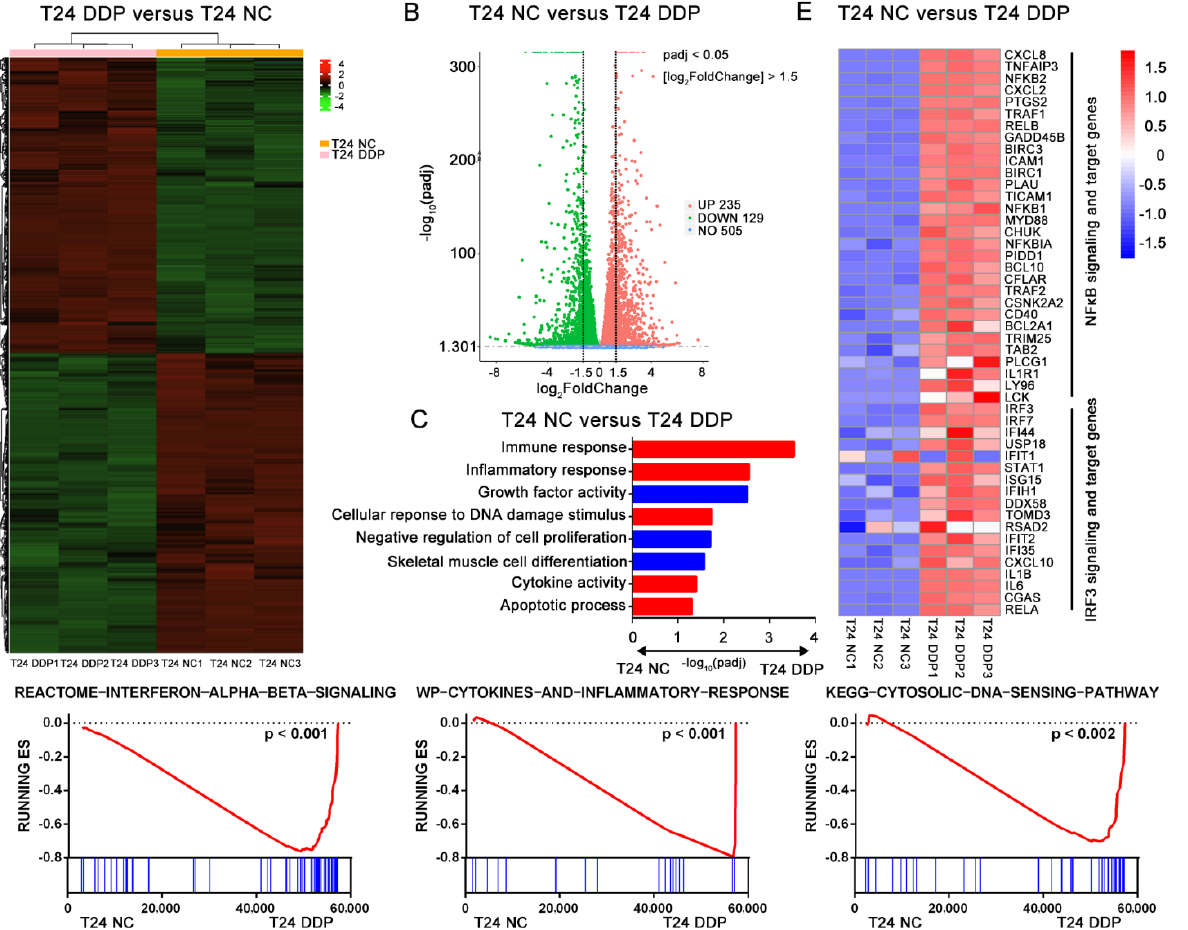
Figure 1. Cisplatin induces specific immune effects in bladder cancer cell line. T24 cell lines were treated with 2 µ g/mL cisplatin (T24 DDP group) or PBS (T24 PBS group) for 24 h at standard condition. ( A ) The different genes expression panels between T24 DDP group and T24 PBS group were showed in heatmap. ( B ) Gene expression levels were quantified as Fragments Per Kilobase Million (FPKM) and then Log 2 –transformed as A value. The significant different expression genes were identified as absolute fold change of A value > 1.5 and Padj (adjust p ) value < 0.05 between two groups. Finally, the volcano map showed 235 up genes and 129 down genes with significant difference. ( C ) Go pathways with Padj value < 0.05 were showed here between T24 DDP group and T24 PBS group. ( D ) Gene set enrichment analysis (GSEA) in: Interferon α , β signaling ( p < 0.001), cytokines and inflammatory response ( p < 0.001) and cytosolic DNA sensing pathway ( p < 0.002). ( E ) Relative transcription levels of genes expression involved in IRF3 and NF- κ B signal pathway or targeting genes in T24 DDP group and T24 PBS group. Gene expressions were normalized by R software from − 1.5 to 1.5 (Low to high, blue to